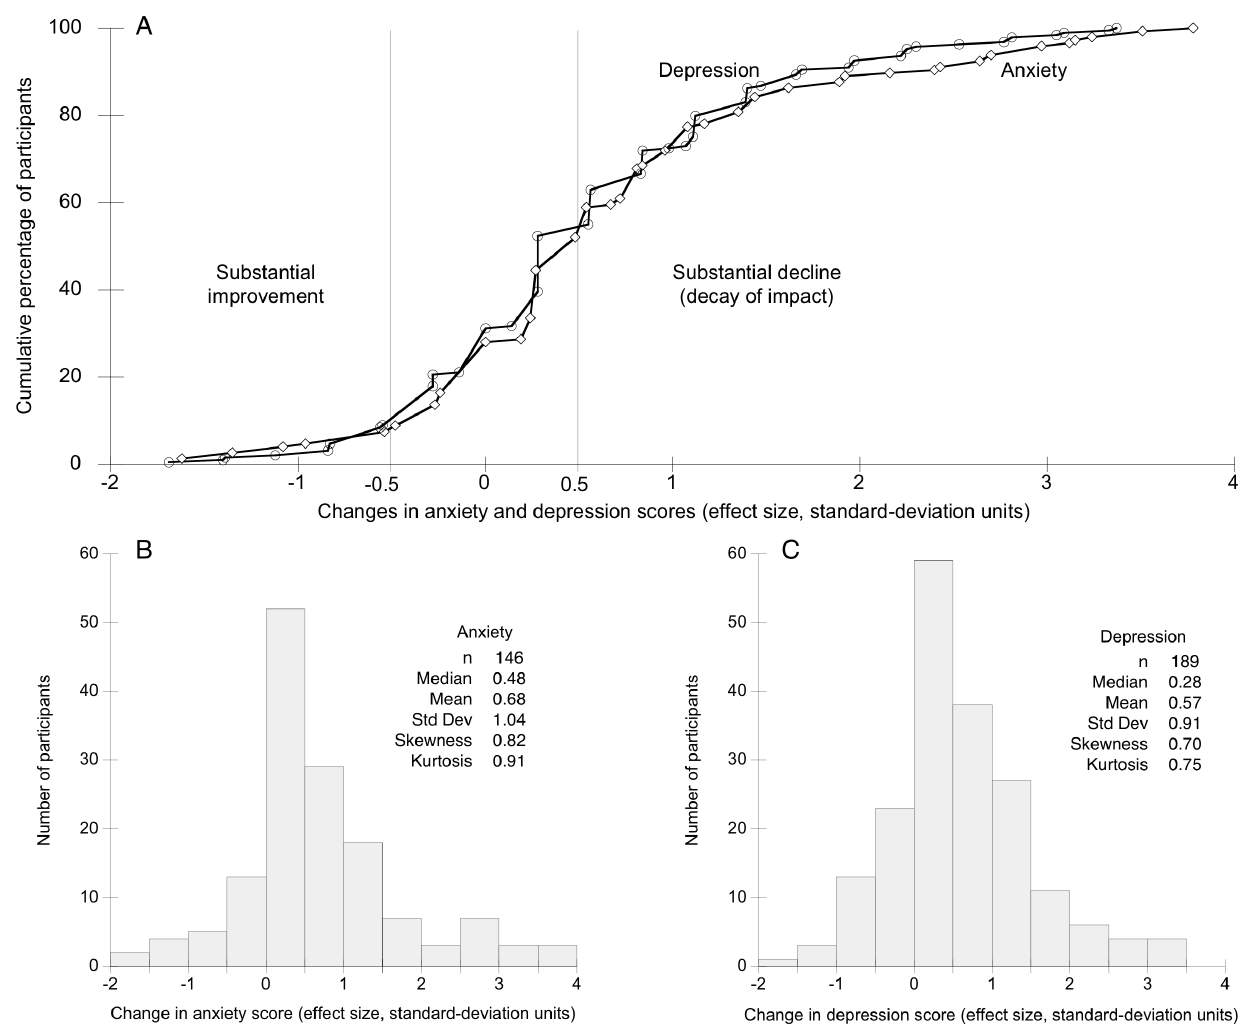
Figure 3. Cumulative frequency distributions and histograms of changes from the time of the best score to the end of the follow-up year. The cumulative frequency distributions in panel (A) show changes in scores on the anxiety and depression scales. On these scales, higher scores indicate more distress. Thus, change scores less than zero indicate improvement and change scores greater than zero indicate decline. Changes are shown in standard-deviation units. Vertical lines indicate half a standard deviation above and below zero. By the definition used in this study, increases of half a standard deviation or more were considered to indicate substantial worsening of anxiety or depression. These results are from participants who had substantial improvement between baseline and 3 months, between baseline and 6 months, or both: n=146 for anxiety, and n=189 for depression. The changes shown occurred between the time of the best score (i.e., at 3 or at 6 months) and the end of the follow-up year. Thus, points to the right of the vertical line at + 0.5 indicate substantial decline in participants who had previously had substantial improvement, i.e. decay of impact. Displays such as (A) illustrate the full range of the measured changes, and allow one to easily see the proportion of participants in whom the magnitude of change meets or exceeds any given value. The histograms in panels (B) and (C) were constructed from the same data used to construct the cumulative frequency distributions in panel (A). Both histograms show distributions that are slightly positively skewed.